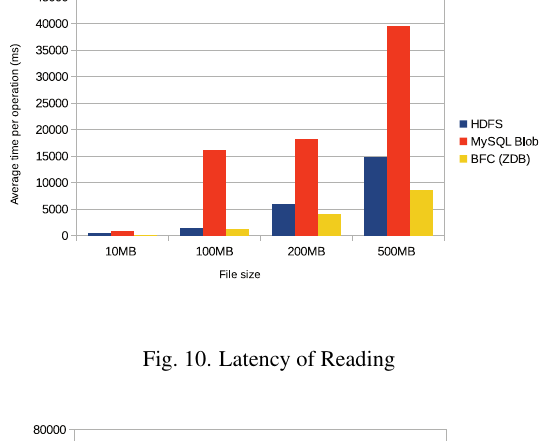
Fig. 10. Latency of Reading